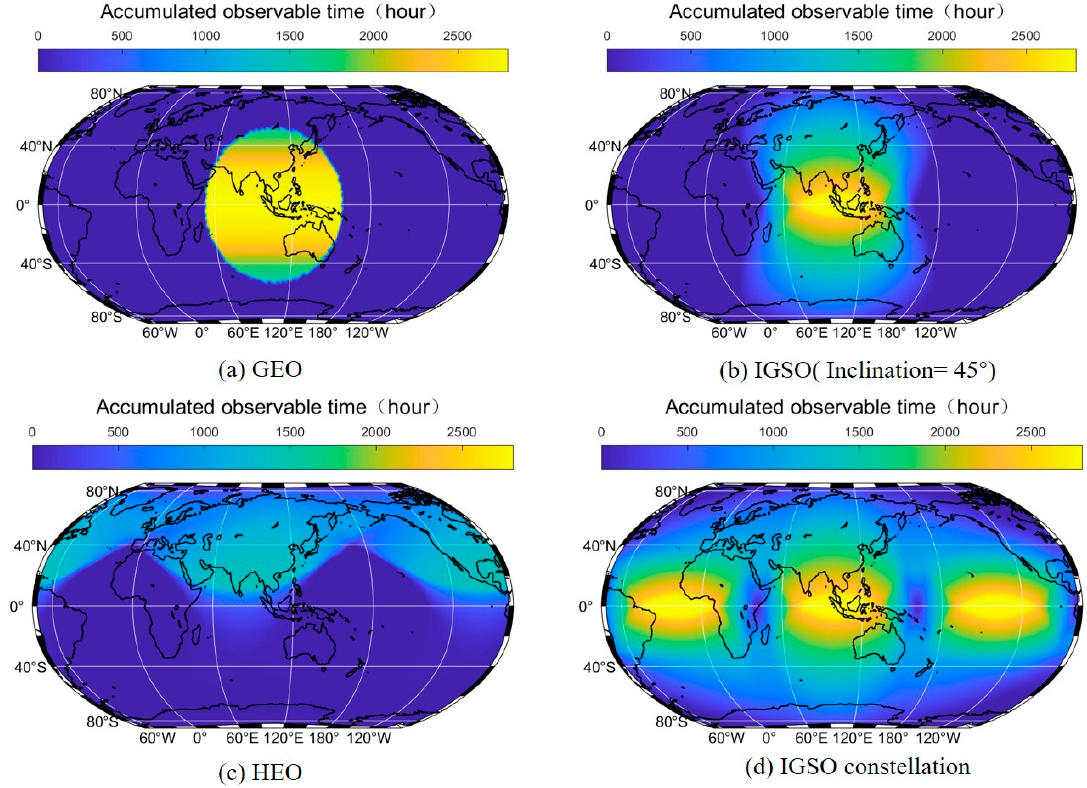
Figure 10. The global accumulated observable time of MS-BiSAR (different configuration) over 2022.